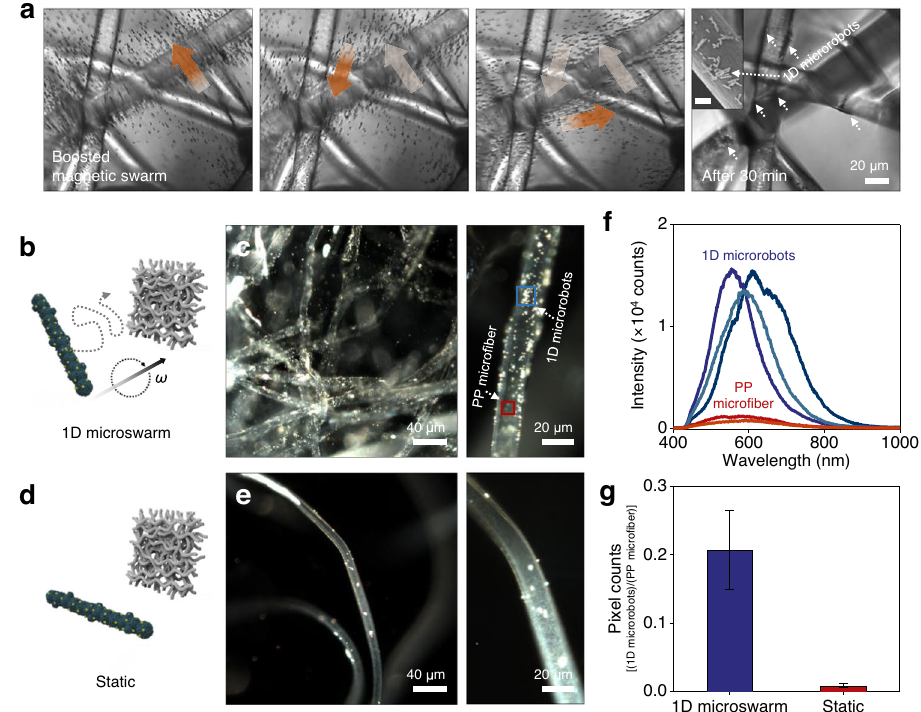
Fig. 5 | Fish schooling-like movement of 1D microswarm and enhanced adhe- sion on the micro fi ber network. a Time-lapse microscopy images illustrating the magnetically boosted 1D microswarm and their robust interaction with the PP micro fi ber network (seealso Supplementary Movie 5).The white arrows in the last imageandinsetSEMimagehighlighttheadhered1Dmicrorobotsonthemicro fi ber network after 30min actuation (Scale bar in the inset is 5 μ m). b – g Hyperspectral dark- fi eld microscopy (HDFM) analysis for the quanti fi cation of the adhered 1D